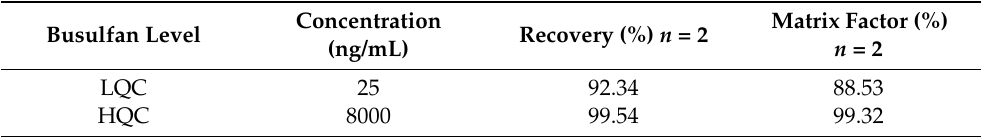
Figure 1. Representative elution chromatograms of busulfan and busulfan-D8 at different levels using newborn calf serum. ( A ) Lower limit of quantitation (LLOQ) at 10 ng/mL busulfan, and ( B ) medium QC (MQC) at 4000 ng/mL busulfan. The SRM transitions were busulfan (264 > 151 m / z , 264 > 151 m / z ) and busulfan-D8 (272 > 159 m / z , 272 > 62 m / z ). Table 1. Recovery and matrix effect tests in QC low (LQC) and high (HQC) levels.